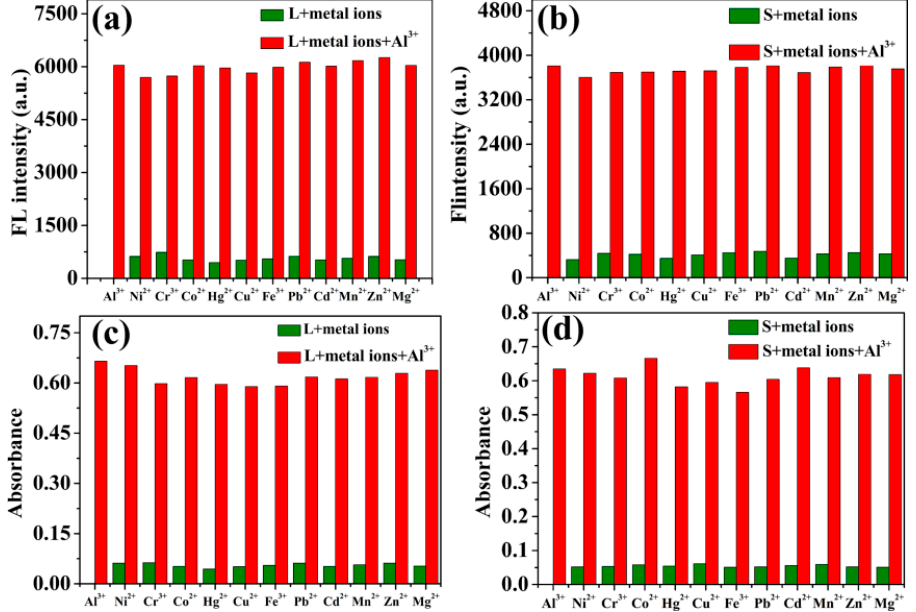
Figure 2. Fluorescence spectra of L ( a ) and S ( b ) (5.0 × 10 − 5 mol/L) with Al 3+ (2.5 × 10 − 4 mol/L), UV spectrum of L ( c ) and S ( d ) solutions after adding Al 3+ ions upon the addition of various metal ions (2.5 × 10 − 4 mol/L) in DMSO/H 2 O ( v / v = 8:2) ( λ ex = 430 nm for L and λ ex = 420 nm for S).